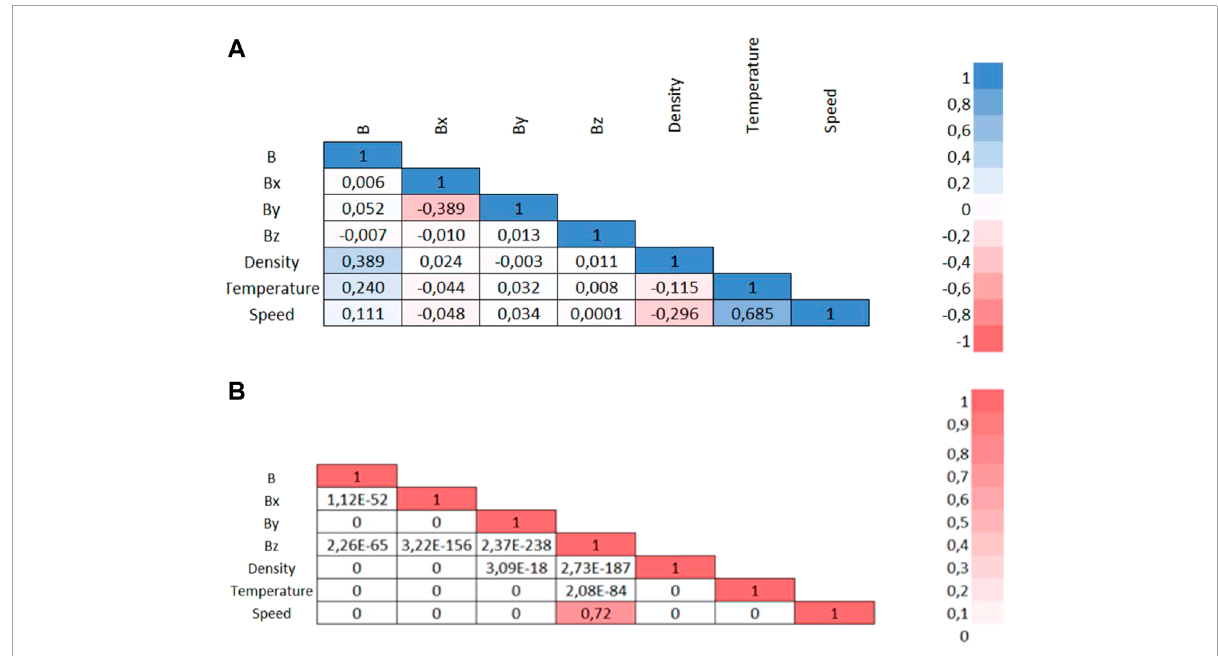
FIGURE 10 Matrices of correlation (A) coefficients for the IMF absolute value and its three components (from ACE’s MAG instrument) and the three parameters (speed, density and temperature) of the solar wind (from ACE’S SWEPAM instrument) and the corresponding p -values (B) . p -values range from 0 to 1, where closed-to-zero values 0 mean the corresponding correlation coefficient is significant (or that there is a low probability of observing the null hypothesis, meaning the correlation coefficients are not random).